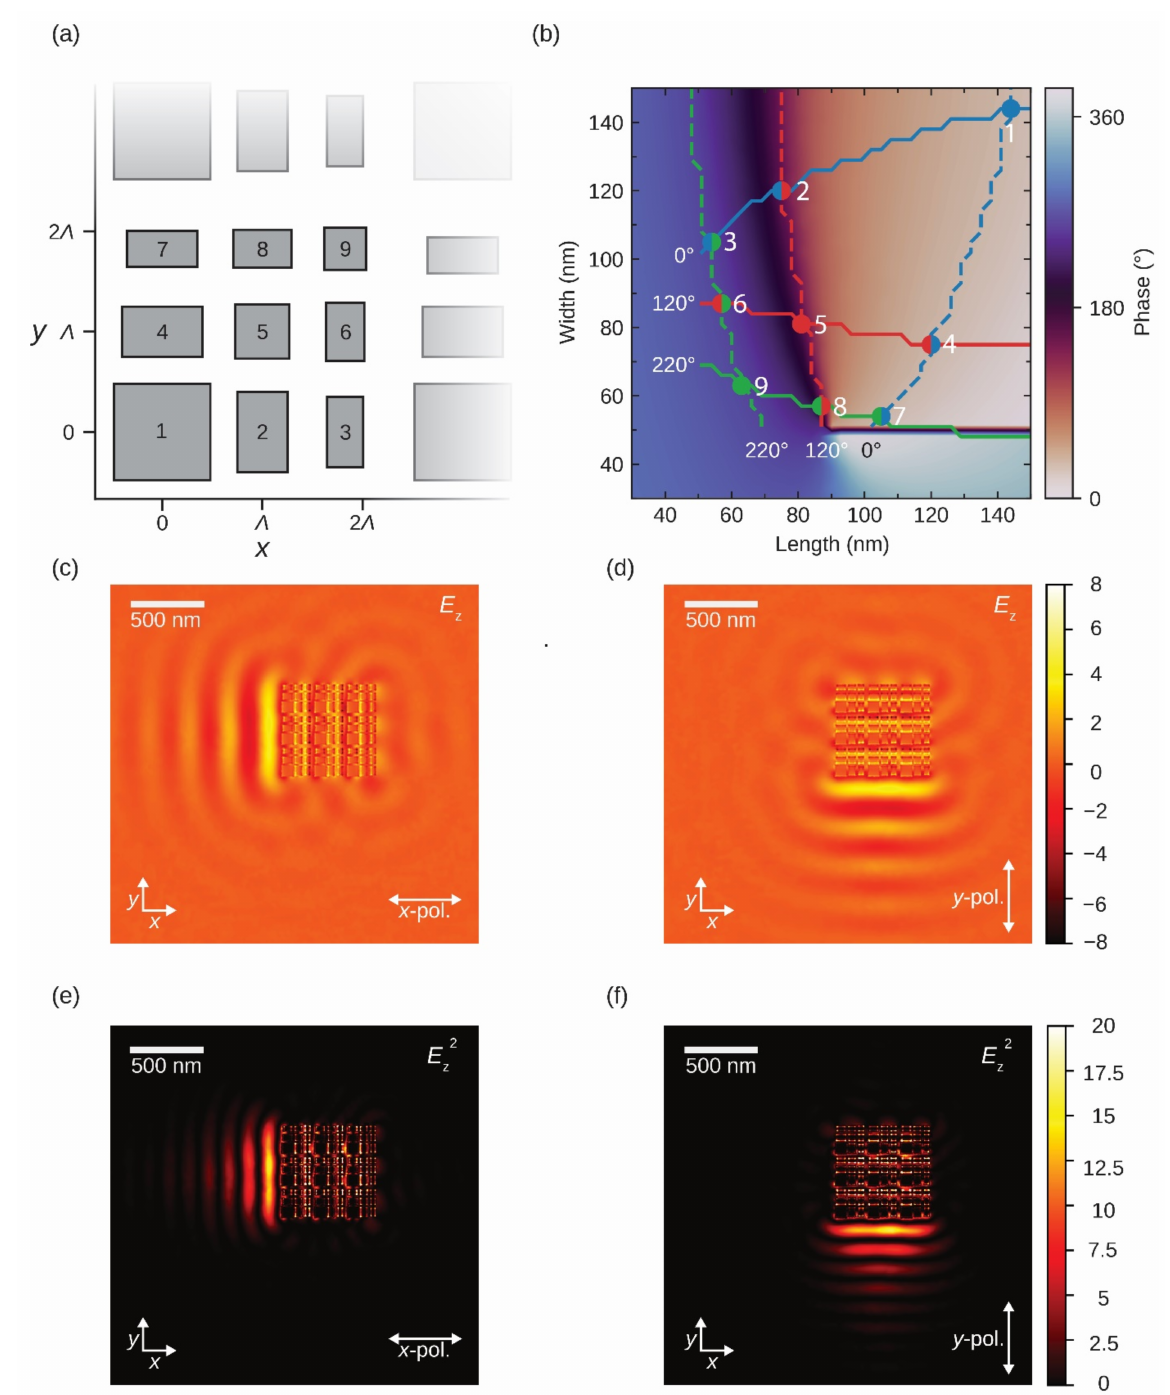
Figure 4. ( a ) Schematics of a birefringent metasurface that was capable of exciting directional SPPs. The supercell consisted of nine nanobricks in a 450 × 450 nm area with an average pitch of Λ . In ( b ), the length and width of a Bi 2 Te 3 nanobrick with a unit cell size of 160 nm and a spacer layer of 30 nm was tuned from 30 to 150 nm, where the color code shows the phase response for x -polarized light. At a 55 nm width, a transition from an overdamped to an underdamped system was visible. The isolines at 0 ◦ , 120 ◦ , and 220 ◦ for x -polarization in the underdamped region are marked with solid lines, while the isolines for the y -polarization are marked with dashed lines. The nine intersection points marked with dots each correspond to one of the bricks in ( a ). Note that unequal phase steps were chosen to create the 2 π phase gradient over the supercell length. To maintain a linear gradient, bricks with 220 ◦ phase responses were slightly shifted. ( c , d ) show the z -component of the electric field for x - and y -polarized light, respectively, while ( e , f ) show the corresponding intensities. ( c – f ) were normalized to the excitation field and reveal highly directional SPP